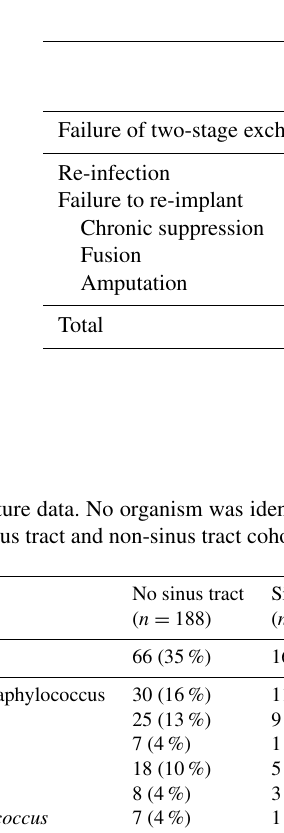
Table 2. Draining sinus as a risk factor. Patients with a draining sinus tract were significantly less likely to undergo re-implantation ( p = 0 . 02).